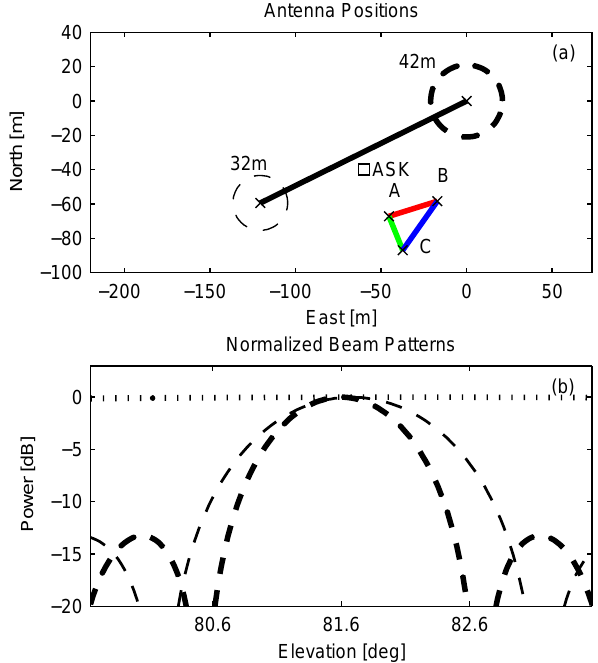
Figure 1. Receiver antennas at the EISCAT Svalbard Radar (ESR). Panel (a) shows the location of the receiver antennas relative to the position of the 42m dish. Baselines employed for the analysis are indicated by lines (blac, red, and green) connecting the involved an- tennas. The position of the ASK instrument is indicated by a square. Panel (b) depicts the normalized antenna beam patterns: 42m as thick dashed line, 32m dashed line, and the phased array receivers with nearly uniform patterns as dotted